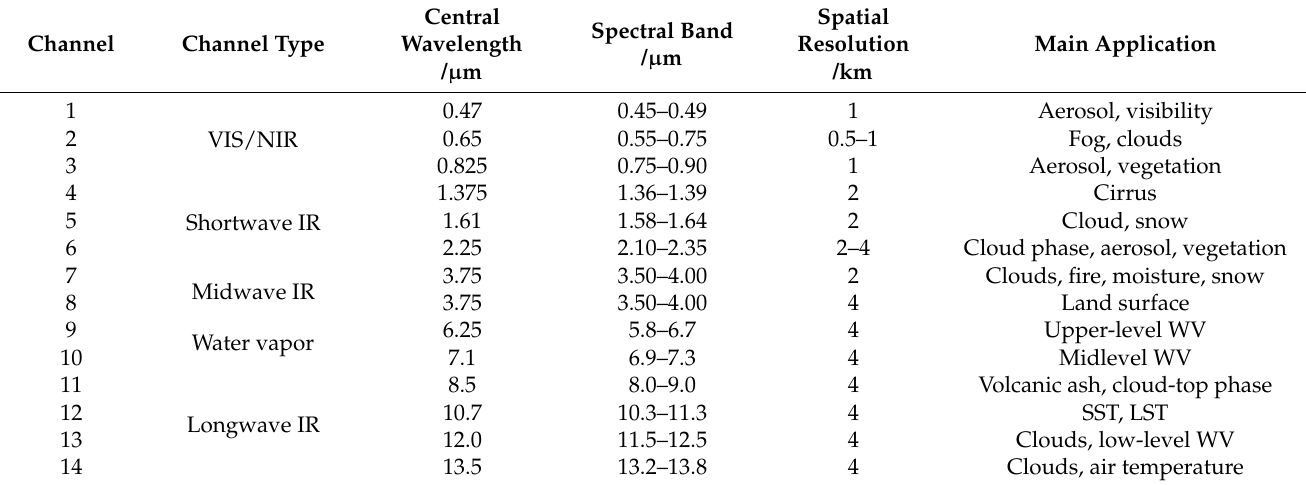
Table 1. Characteristics of FY-4A AGRI for each